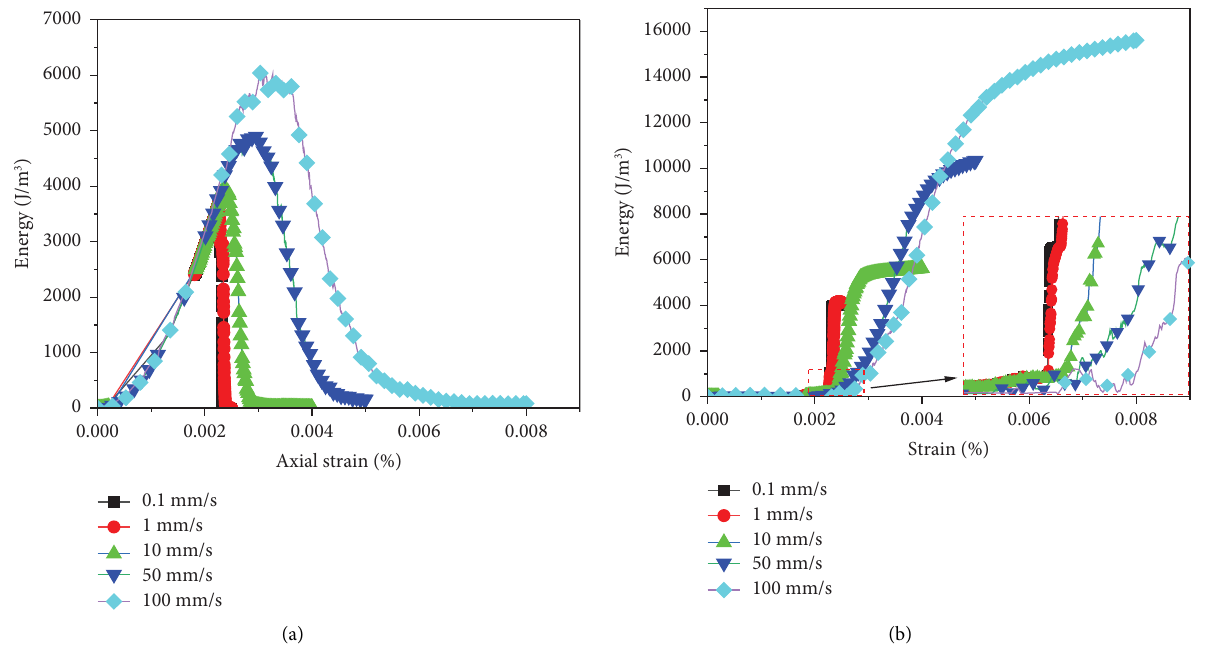
Figure 13: Schematic of energy evolution at diferent loading rates. (a) Elastic energy evolution. (b) Dissipative energy evolution